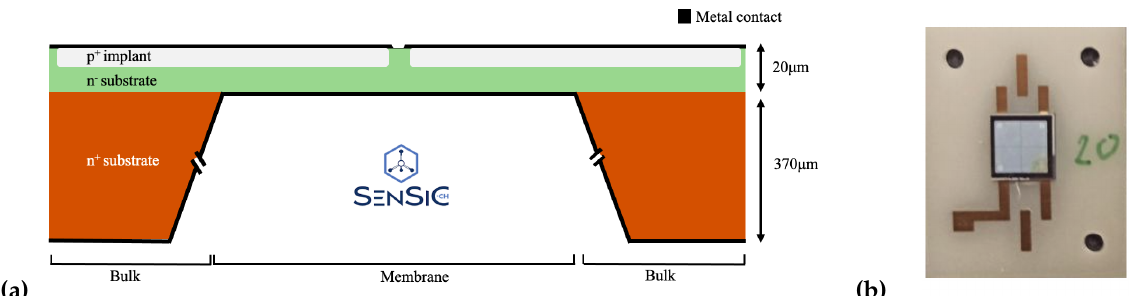
Figure 2. ( a ) The structure of the SiC membrane sensor is shown: a thin p + layer, an n − layer, and a thick n + substrate. The central area at the four pads (circular region of ∼ 2 mm diameter) is thinned